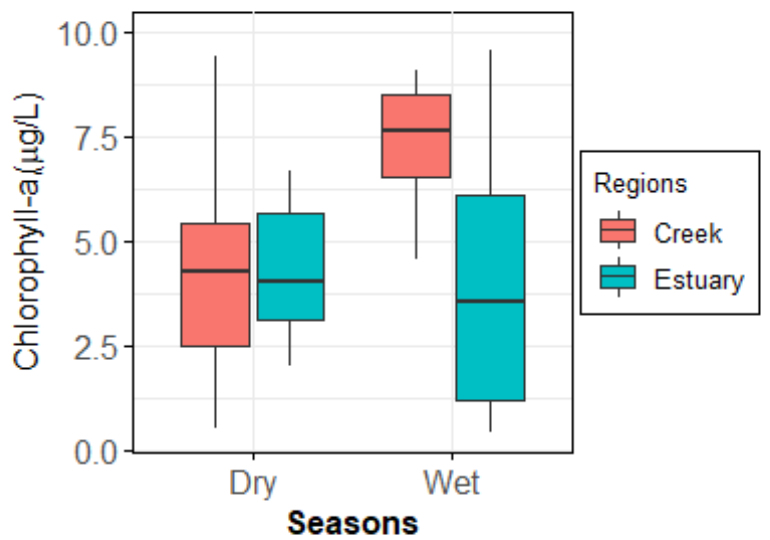
Figure 3. Spatial and temporal variation of chlorophyll a.